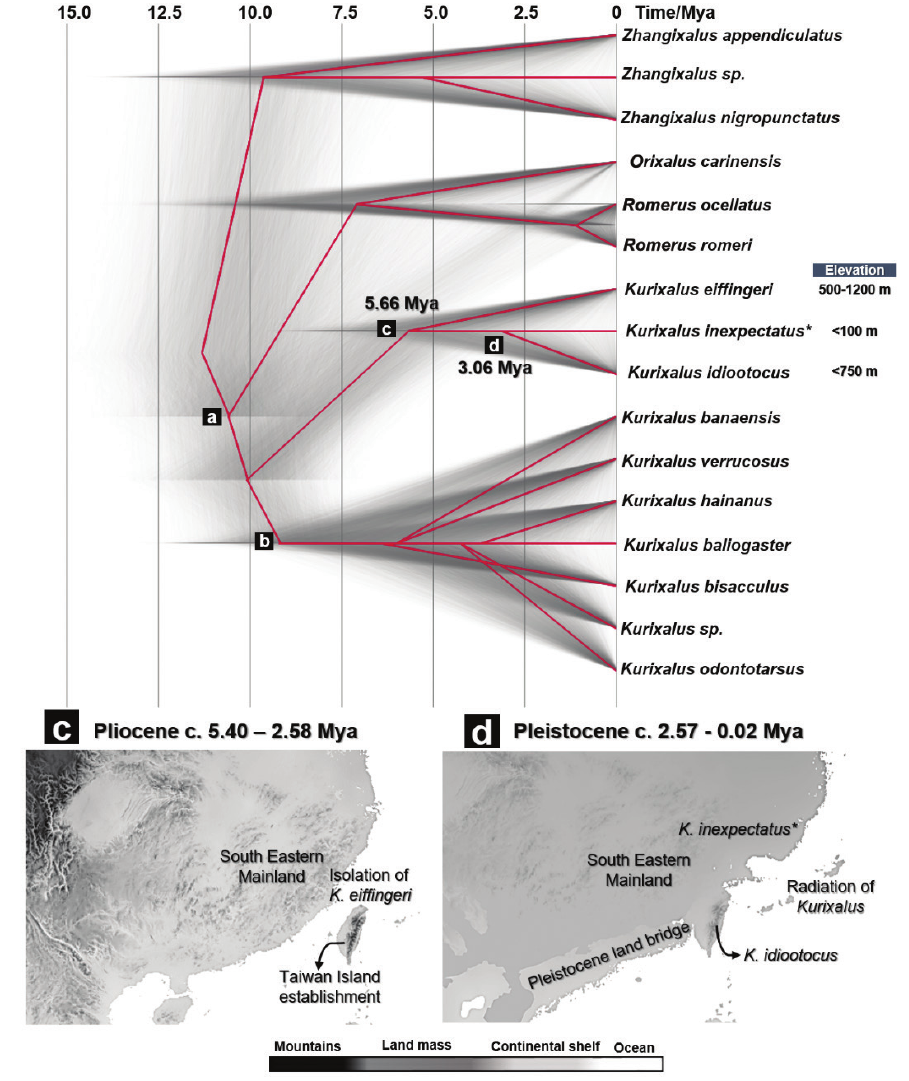
Figure 6. Calibrated species tree of Rhacophoridae represented by Kurixalus , Orixalus , Romerus and Zhang- ixalus distributed over East Asia and Southeast Asia. The species tree reconstructed from unlinked 12S rRNA and TYR . The asterisk (*) symbol indicates Kurixalus inexpectatus sp. nov. The highlighted lineages divergence noted with ( a–d ) and the time estimates are synchronised with datation in Table 6. Biogeogra- phy models C and D hypothesised early colonisation pathway of Kurixalus to Taiwan Island and potential glacial-driven refugia to the south-eastern mainland, projected on the Plio-Pleistocene oscillations models